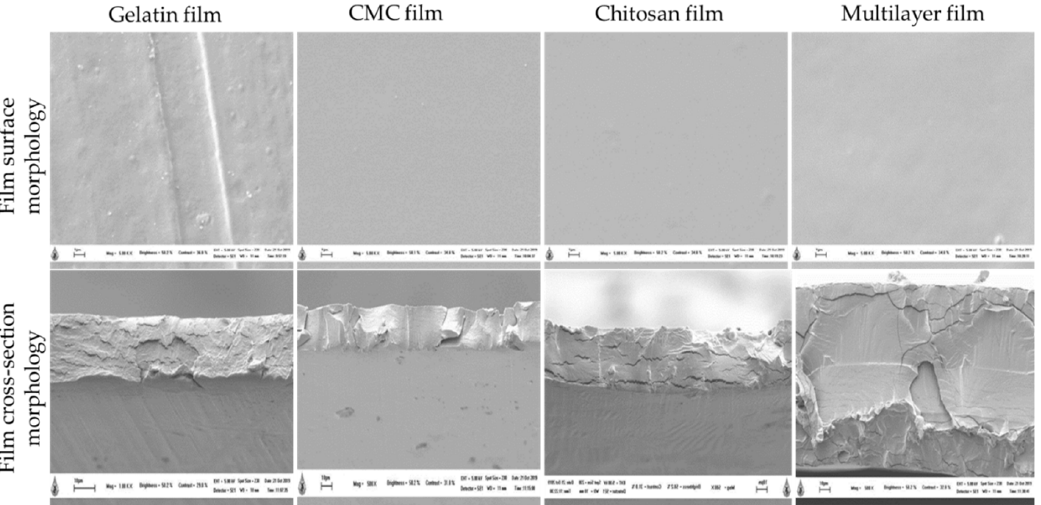
Figure 1. Microstructure of surface morphology and cross ‐ section of the developed film at 500×